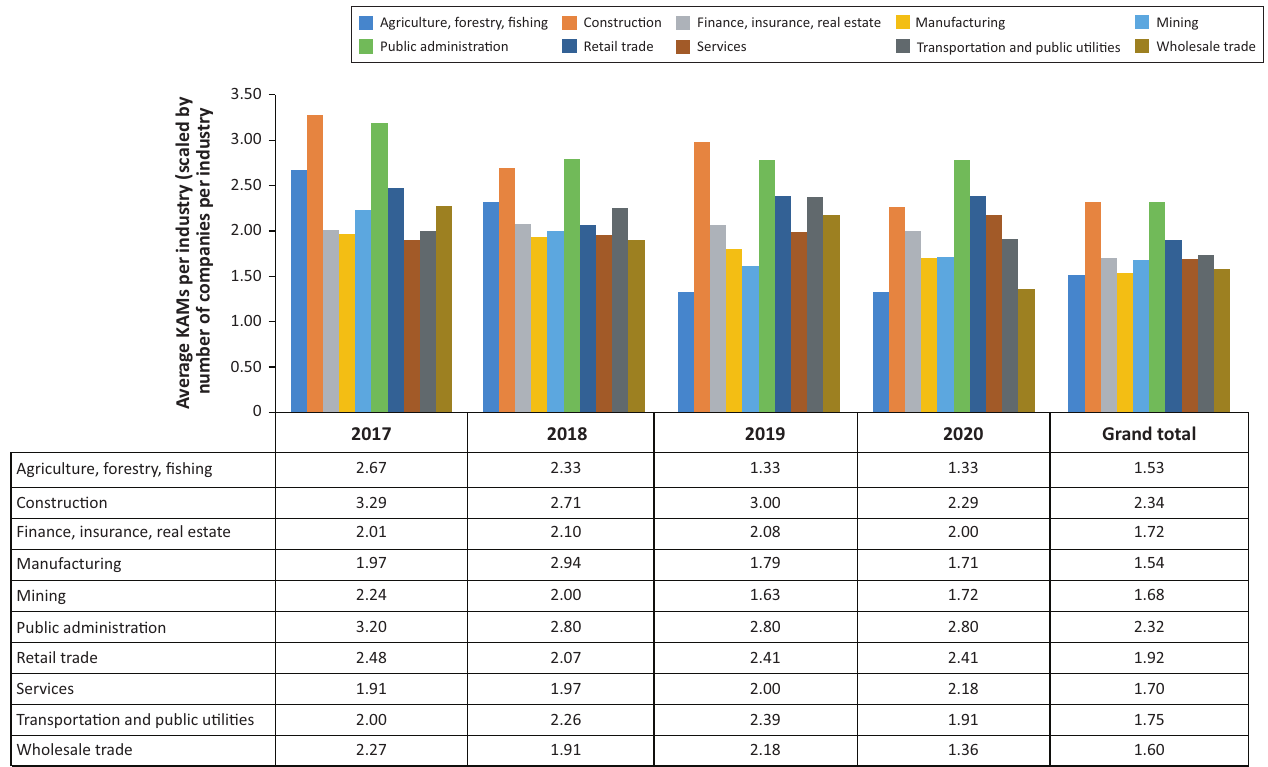
Figure 4 examines how KAMs differ among industries after controlling for differences in the number of companies per